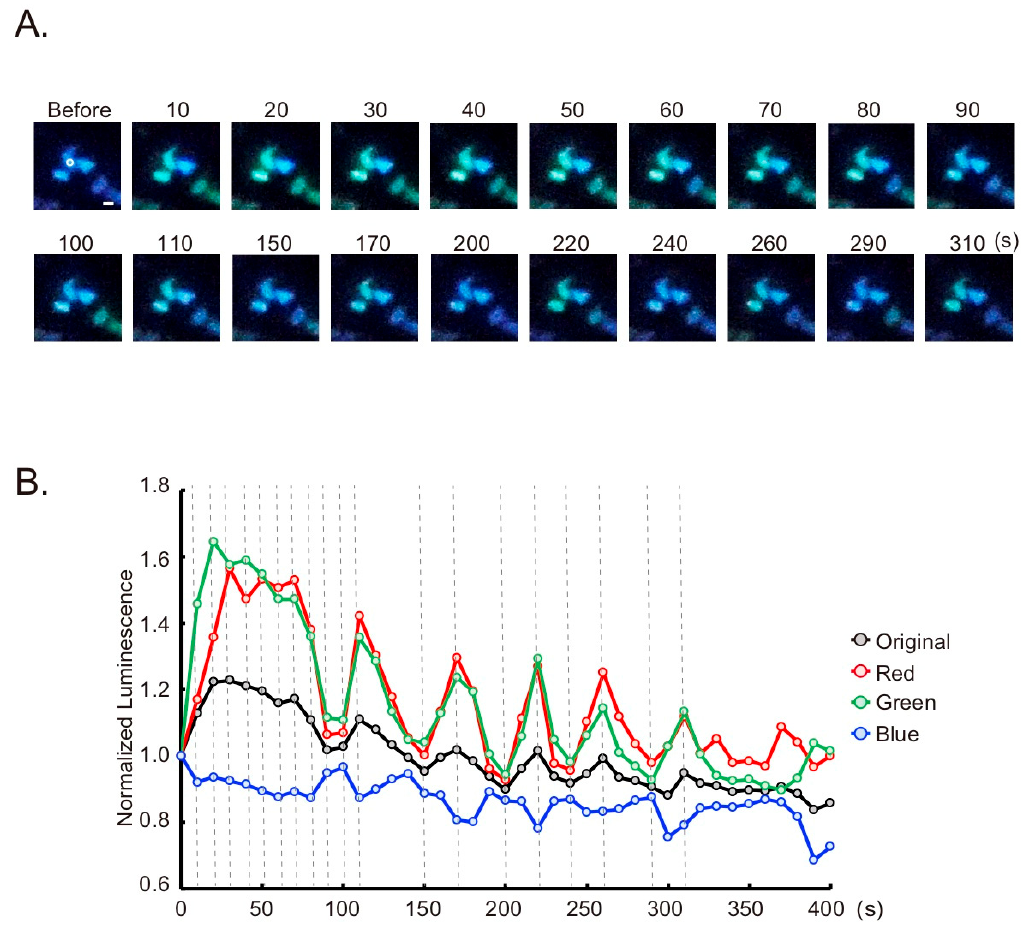
Figure 5. Ca 2 + imaging with CalfluxVTN in HeLa cells based on the smartphone microscope. ( A ) Time-lapse bioluminescence images of CalfluxVTN in cytosol. Cells were stimulated by histamine. The numbers indicate the elapsed time after stimulation. Scale bar, 20 µ m. ( B ) Time-course variation of bioluminescence intensity in cells. The intensity was measured for each color image separated from the original (Figure S4). Region of interest (ROI) for the measurement is shown as the white circle in A. The x -axis shows the elapsed time after the stimulation (at 0). Broken lines indicate the time points of selected images in A.